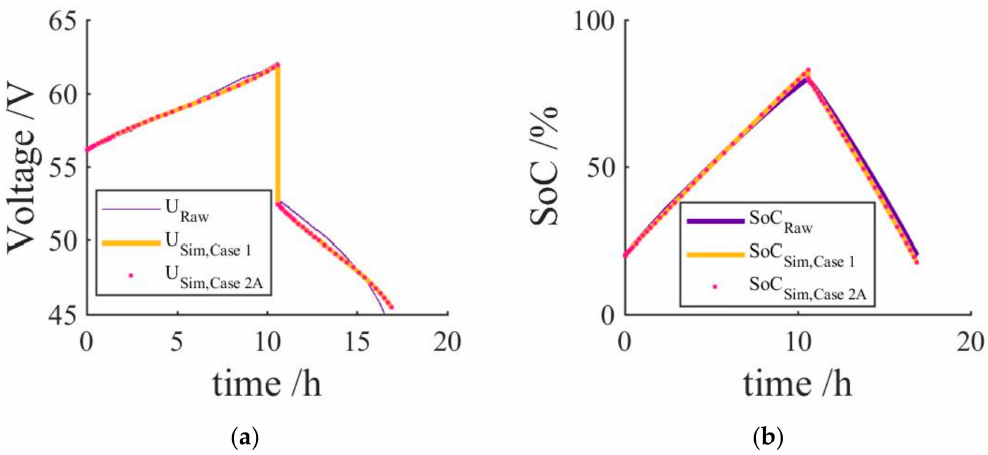
Figure 3. Comparison between simulation model and measurements using fitting Case 1 and Case 2A: ( a ) Voltage with P apl = 10 kW; ( b ) SoC with P apl = 10